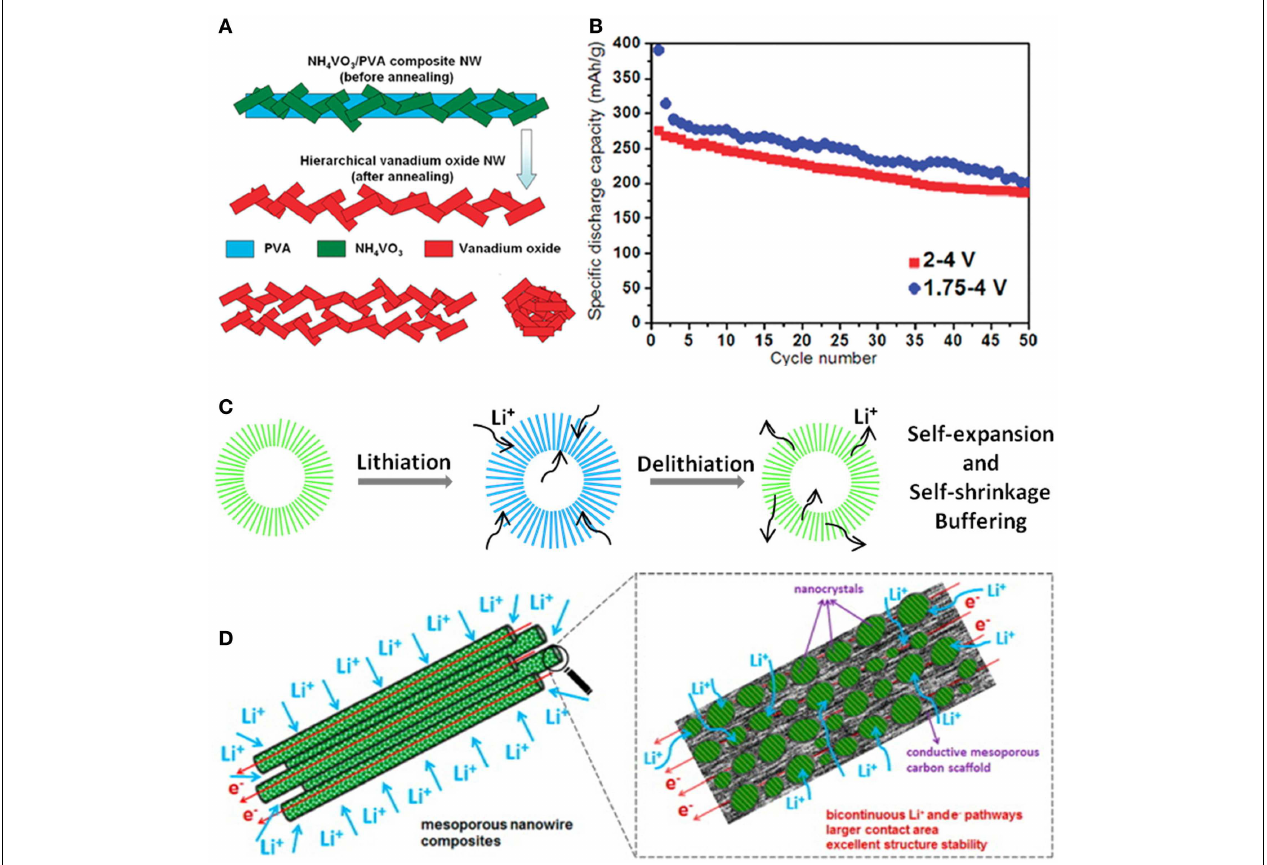
electron/ion transport pathways, larger electrode–electrolyte contact area, and facile strain relaxation during Li + extraction/insertion (Wei et al., 2014). Reprinted with permission from Mai et al. (2010b), Niu et al. (2014), andWei et al. (2014). Copyright 2010 American Chemical Society, 2014 American Chemical Society, and 2013 American Chemical